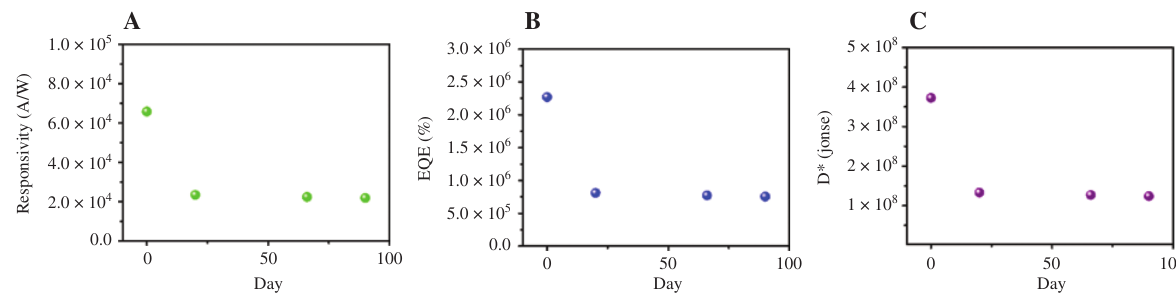
Figure 5: Aging characterization of the Te NS photodetector under ambient conditions. Photodetection of the Te NS photodetector at 261 nm. (A) Responsivity of the Te NS photodetector at V = 3 V. (C) D * with the measured bias at V photodetector at V g